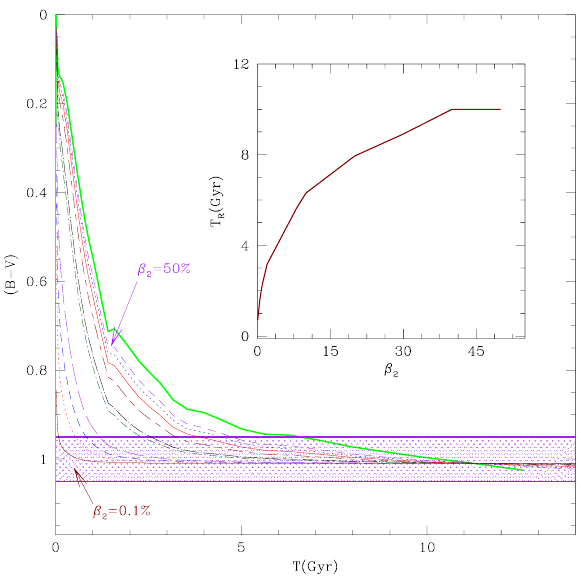
Figure 6. Simulations of the scatter in the (B-V) colour of ETGs, induced by secondary episodes of SF, as a function of the burst age T 0.025, typical mean value for ETGs. The burst intensity β = 0.95 ± total baryonic mass, i.e. , the relation β by 100. The age is in Gyr. Reproduced with permission from [57]. Copyright 2004 John Wiley &